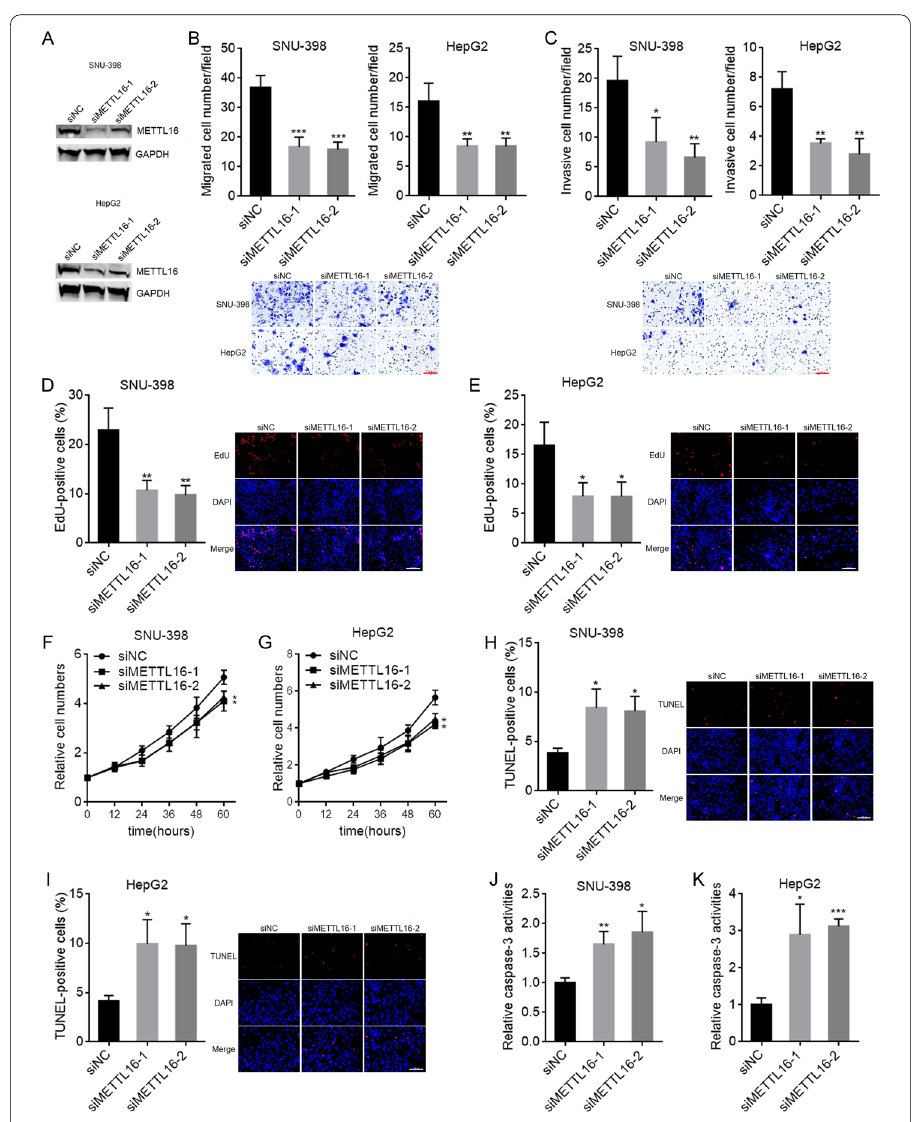
Fig. 3 The roles of METTL16 knockdown in HCC. A METTL16 protein expression in SNU‑398 and HepG2 cells with METTL16 knockdown or control was detected by western blot. B Migration ability of SNU‑398 and HepG2 cells with METTL16 knockdown or control was detected by transwell migration assay. Scale bars, 100 µm. C Invasion ability of SNU‑398 and HepG2 cells with METTL16 knockdown or control was detected by transwell invasion assay. Scale bars, 100 µm. D Cellular proliferation of SNU‑398 cells with METTL16 knockdown or control was detected by EdU assay. Scale bars, 100 µm. E Cellular proliferation of HepG2 cells with METTL16 knockdown or control was detected by EdU assay. Scale bars, 100 µm. F Cellular proliferation of SNU‑398 cells with METTL16 knockdown or control was detected by CCK‑8 assay. G Cellular proliferation of HepG2 cells with METTL16 knockdown or control was detected by CCK‑8 assay. H Cellular apoptosis of SNU‑398 cells with METTL16 knockdown or control was detected by TUNEL assay. Scale bars, 100 µm. I Cellular apoptosis of HepG2 cells with METTL16 knockdown or control was detected by TUNEL assay. Scale bars, 100 µm. J Cellular apoptosis of SNU‑398 cells with METTL16 knockdown or control was detected by caspase‑3 activity assay. K Cellular apoptosis of HepG2 cells with METTL16 knockdown or control was detected by caspase‑3 activity assay. Results are shown as mean s.d. of n 3 independent experiments. ± = * P < 0.05, ** P < 0.01, *** P < 0.001 by one‑way ANOVA followed by Dunnett’s multiple comparisons